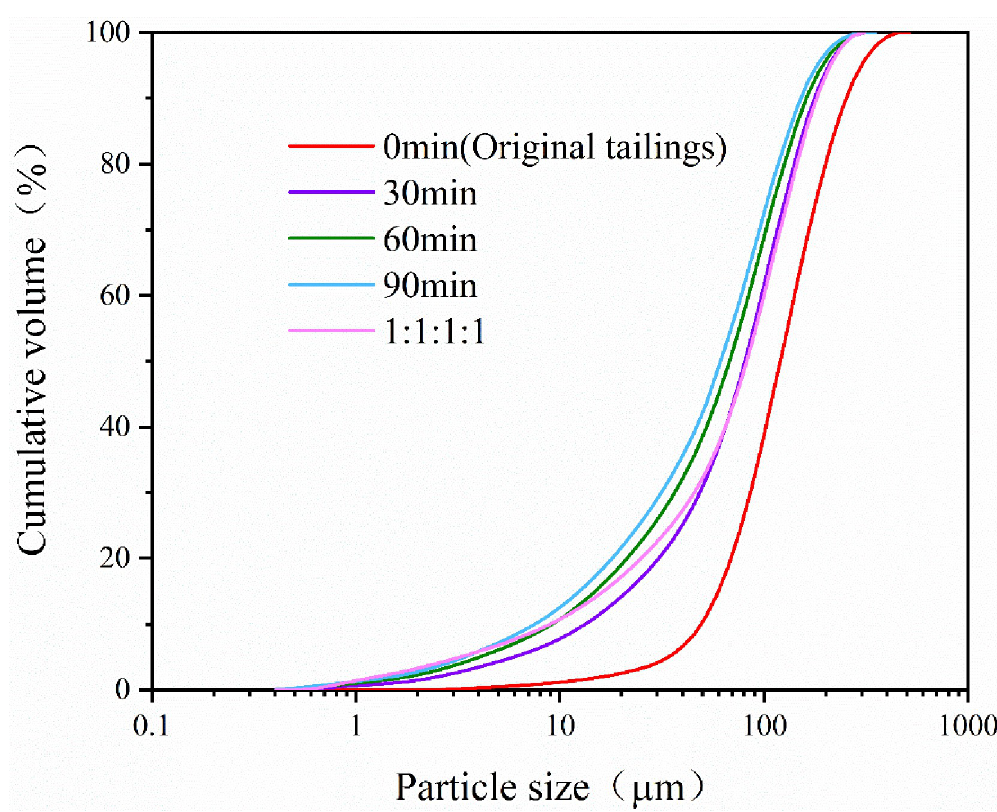
Fig 2. Particle size distribution of tailings with different grinding time.